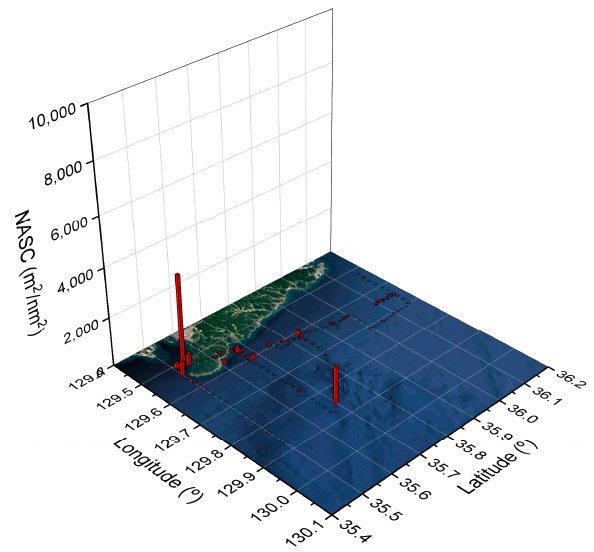
Figure 13. Spatiotemporal distribution of anchovy.